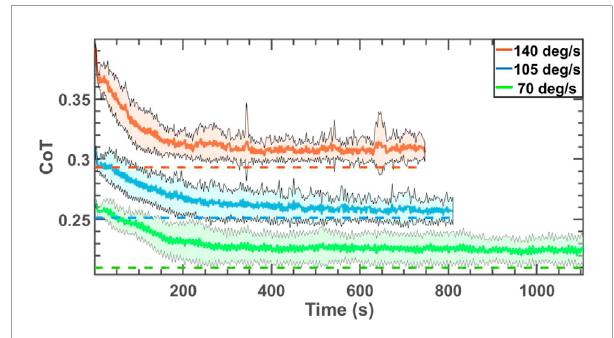
FIGURE 5 CoT of the robot trotting on uneven grounds with the mean slope of zero and three different angular velocities. The dotted lines display the optimal values corresponding to the curve with the same color. The duration of simulations is different for the three cases because the angular velocities are different for the three different cases, and the stride angle of the robot evolves differently for each operating